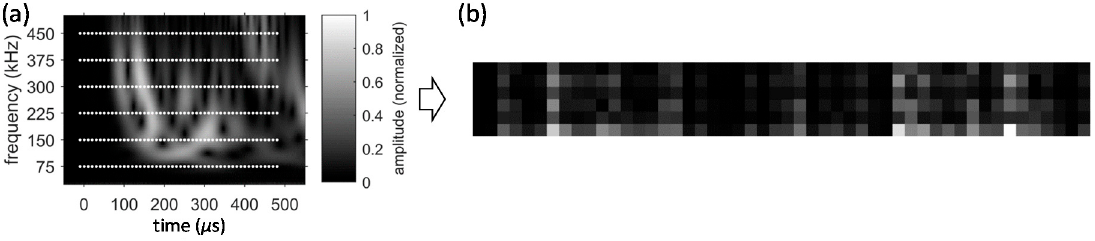
Figure 6. The process of producing the input image to the convolutional neural network: ( a ) a normalized continues wavelet transform, sampled pixels are overlaid, ( b ) the constructed